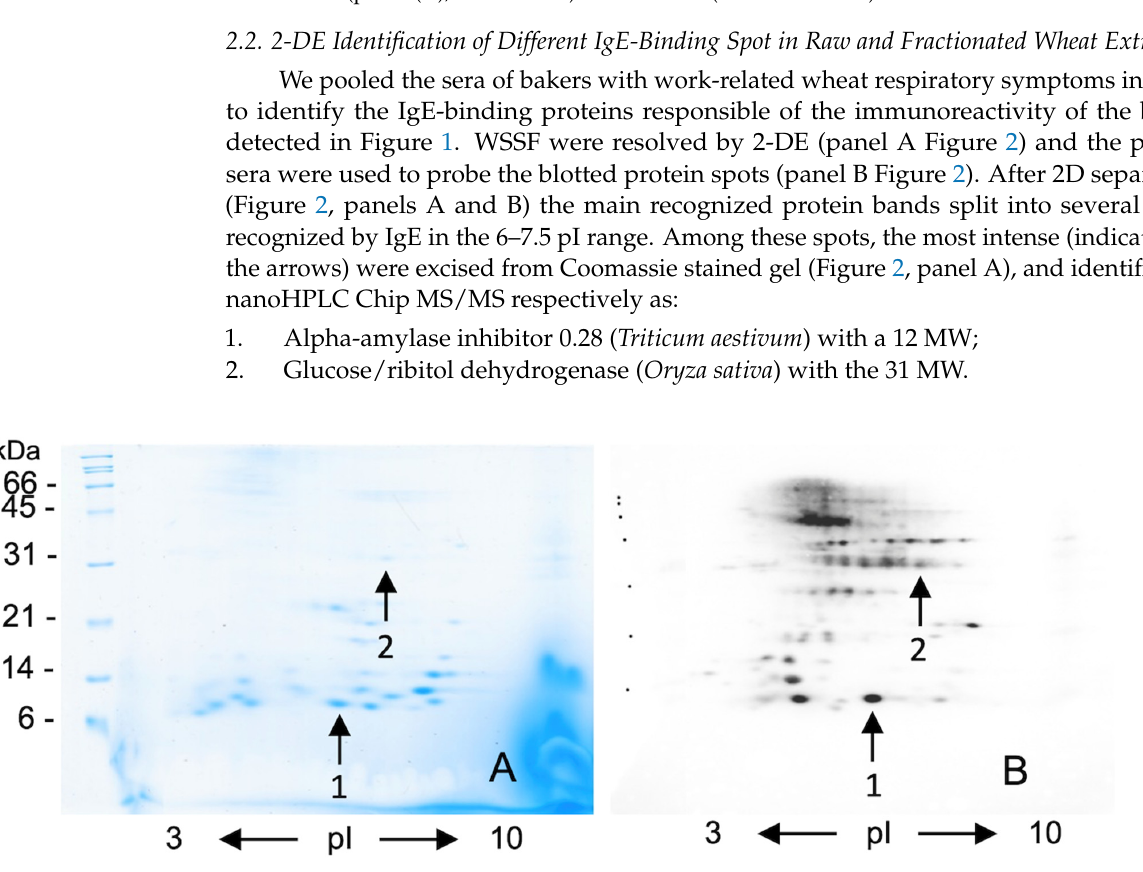
Figure 3. Panel ( A ): 16% SDS-PAGE, Lane 1: MW markers; lane 2: total WSSP, lanes from 3 to 15: fractionated WSSP by electroendosmotic preparative gel electrophoresis. The arrows indicate the fractions resolved by 2-DE and IgE-Blotting (panel ( B , C ) respectively). Arrow (3) in panel ( D ) indicates the spot identified as 16.9 kDa class I heat shock protein 1, while the two arrows in panel E indicate the spots identified as triosephosphate isomerase (4) and thioredoxin peroxidase (5), respectively. 3. Discussion Baker’s asthma and rhinitis are the most frequent form of occupational respiratory diseases, due to a lot of wheat allergens. As well reviewed by Brant, the traditional handcraft bakery is rapidly transforming and, in many countries, new workforces, as supermarkets employees, are identified at risk of inhalant wheat flour allergy [28]. The changes of job task exposure are further associated with technological innovation in bread making as well as the use of multi-grain flours from other cereals or enzymes. These innovations induce a progressive challenge of allergen exposures in bakeries. When dealing with bakers allergic to wheat flour, other variables should be considered like the specific wheat cultivars utilized in milling, and other factors that could produce different allergen content and expression in flours. Although it seems that there are no clinically significant differences in the allergenicity of wheat of different species, without considering the more than 25,000 cultivars, the different clinical symptoms and allergen-associated could vary with the different wheat species or patients in different